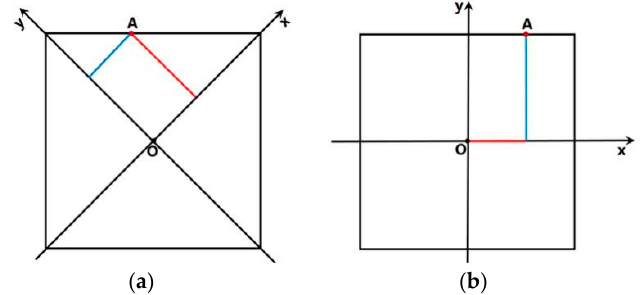
Figure 4. The axial directions of the Manhattan distance and Chebyshev distance: ( a ) Manhattan distance; ( b ) Chebyshev distance.